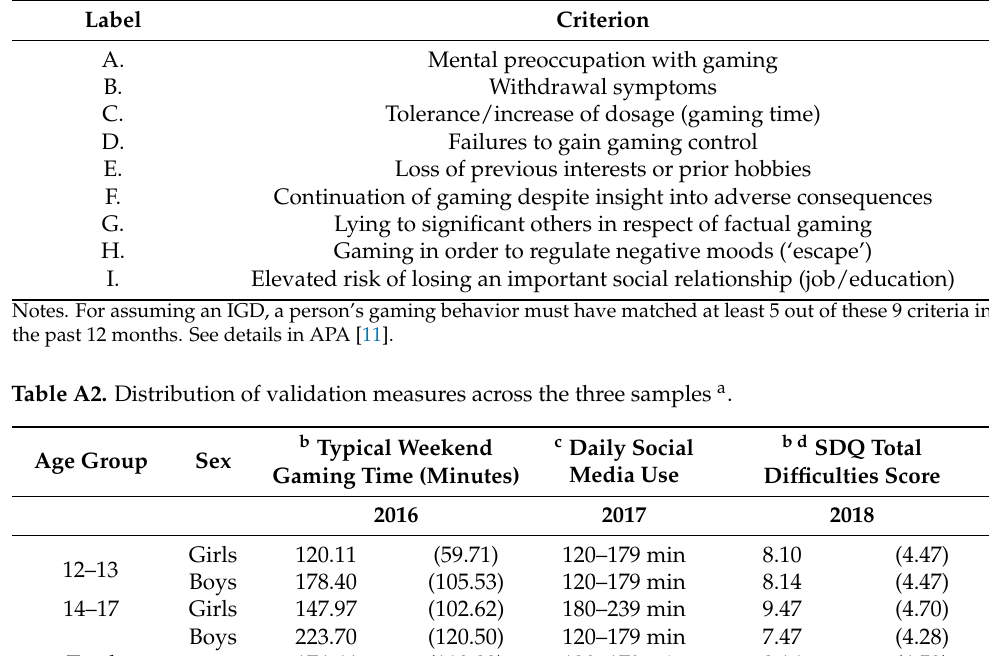
Table A1. Brief overview of diagnostic criteria for the internet gaming disorder (IGD).